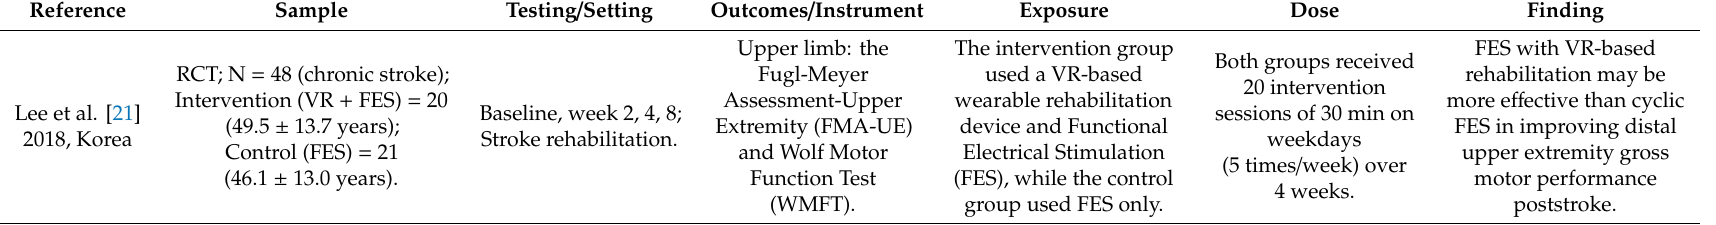
Table 2. Descriptive characteristics of included